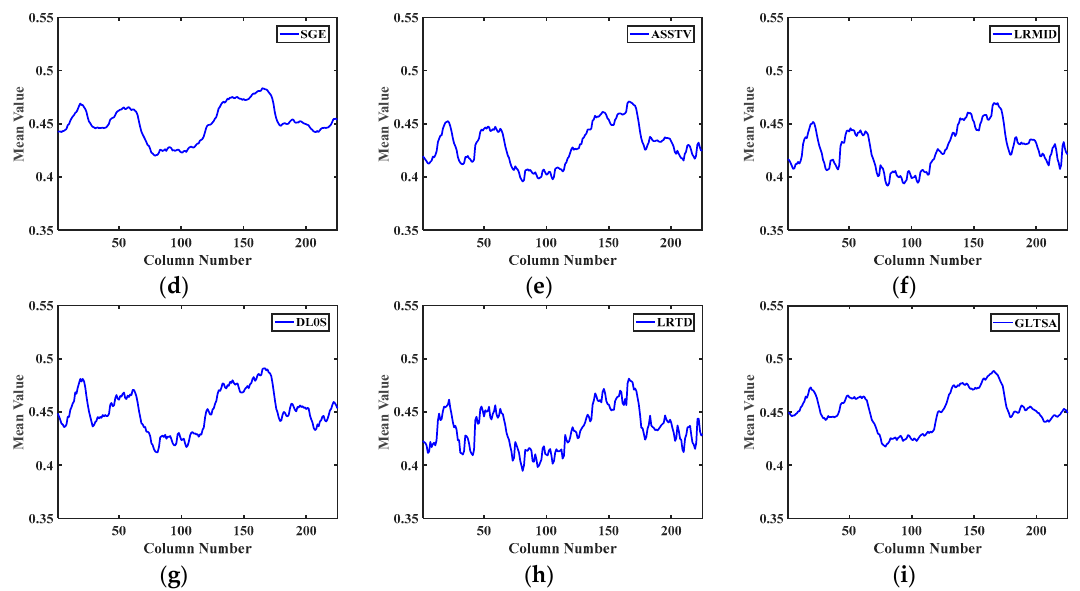
Figure 12. Spatial mean cross-track profiles for the second real data: ( a ) real image; and destriping results by ( b ) UTV, ( c ) WFAF, ( d ) SGE, ( e ) ASSTV, ( f ) LRMID, ( g ) DL0S, ( h ) LRTD, and ( i ) GLTSA.